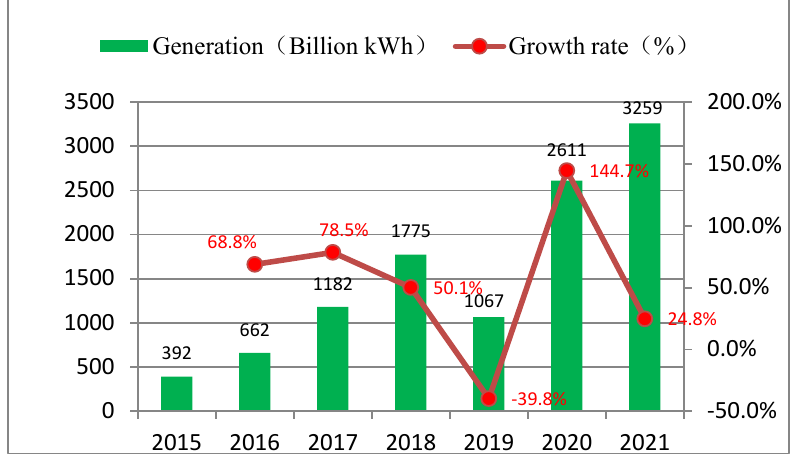
Figure 5. China’s photovoltaic power generation and growth rate from 2015 to 2021. Large-scale wind power photovoltaic-based projects focusing on deserts, Gobi, and desert areas will be connected to the grid and put into operation in 2022. The concentration of new energy projects will increase, and the power generation in the west and north will increase rapidly [31]. National strategies such as “numbering the east and counting the west” will also promote the rapid growth of social electricity consumption in the western region and improve the consumption level of new energy power in the region.